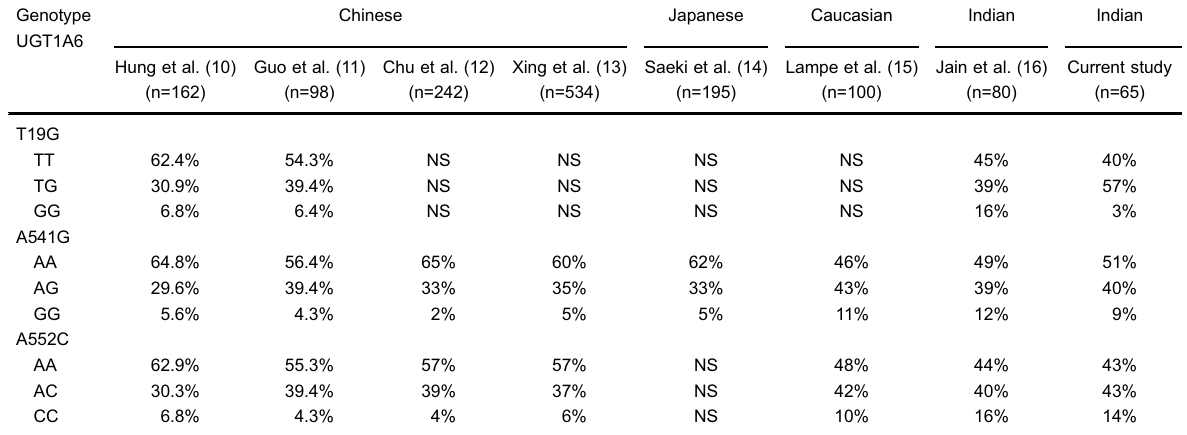
Table 6. Prevalence of UGT1A6 gene polymorphisms in children with epilepsy of various populations based on published